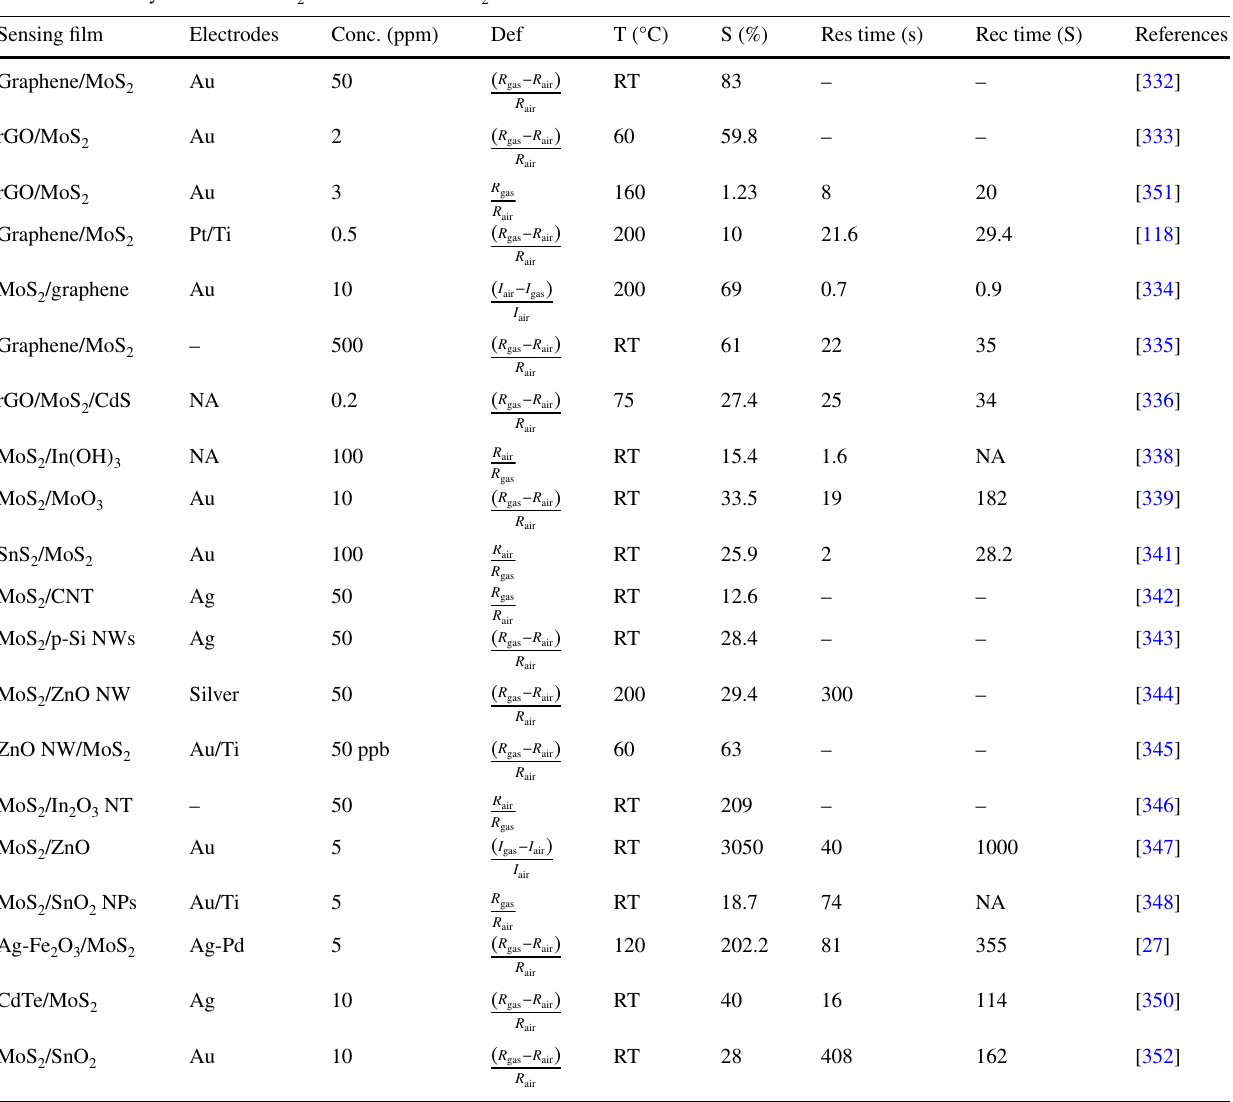
Table 5 Summary of various MoS 2 heterostructures NO 2 sensors Sensing film